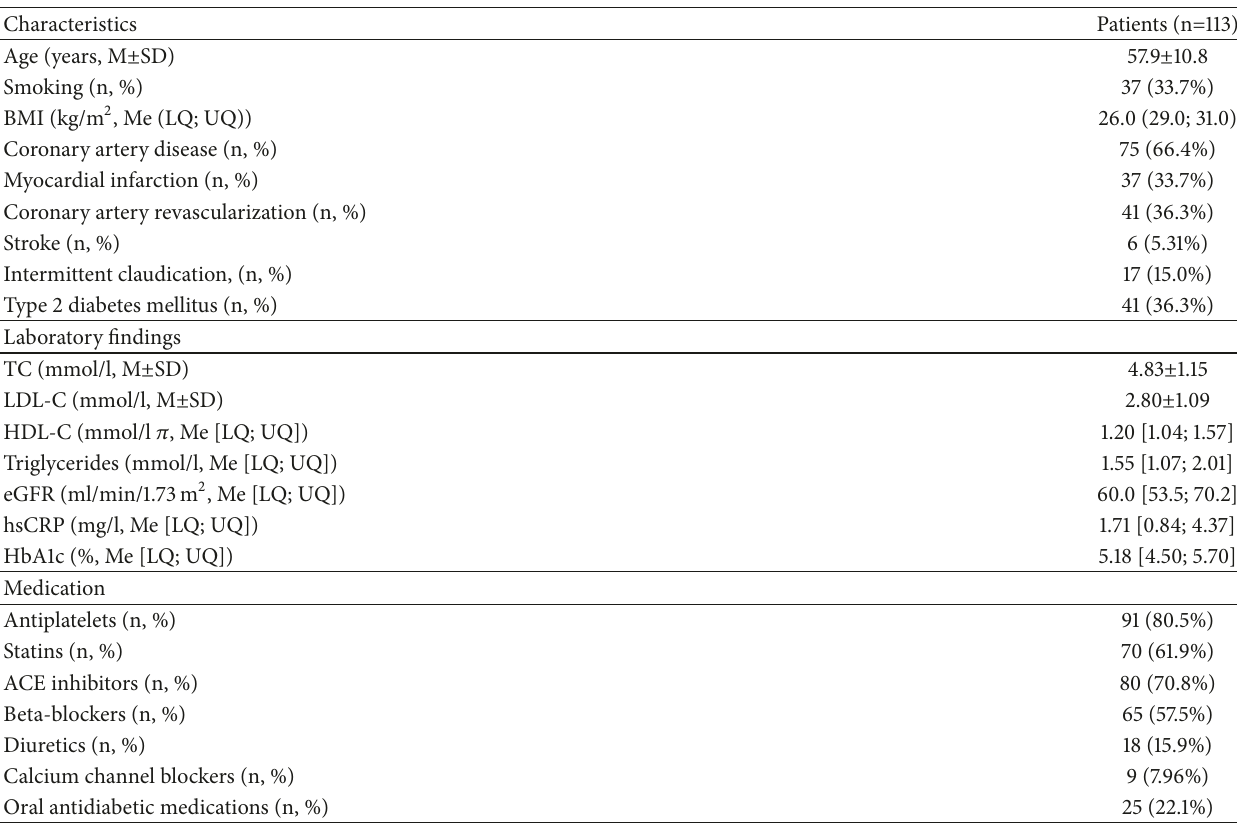
Table 1: Clinical and laboratory characteristics of